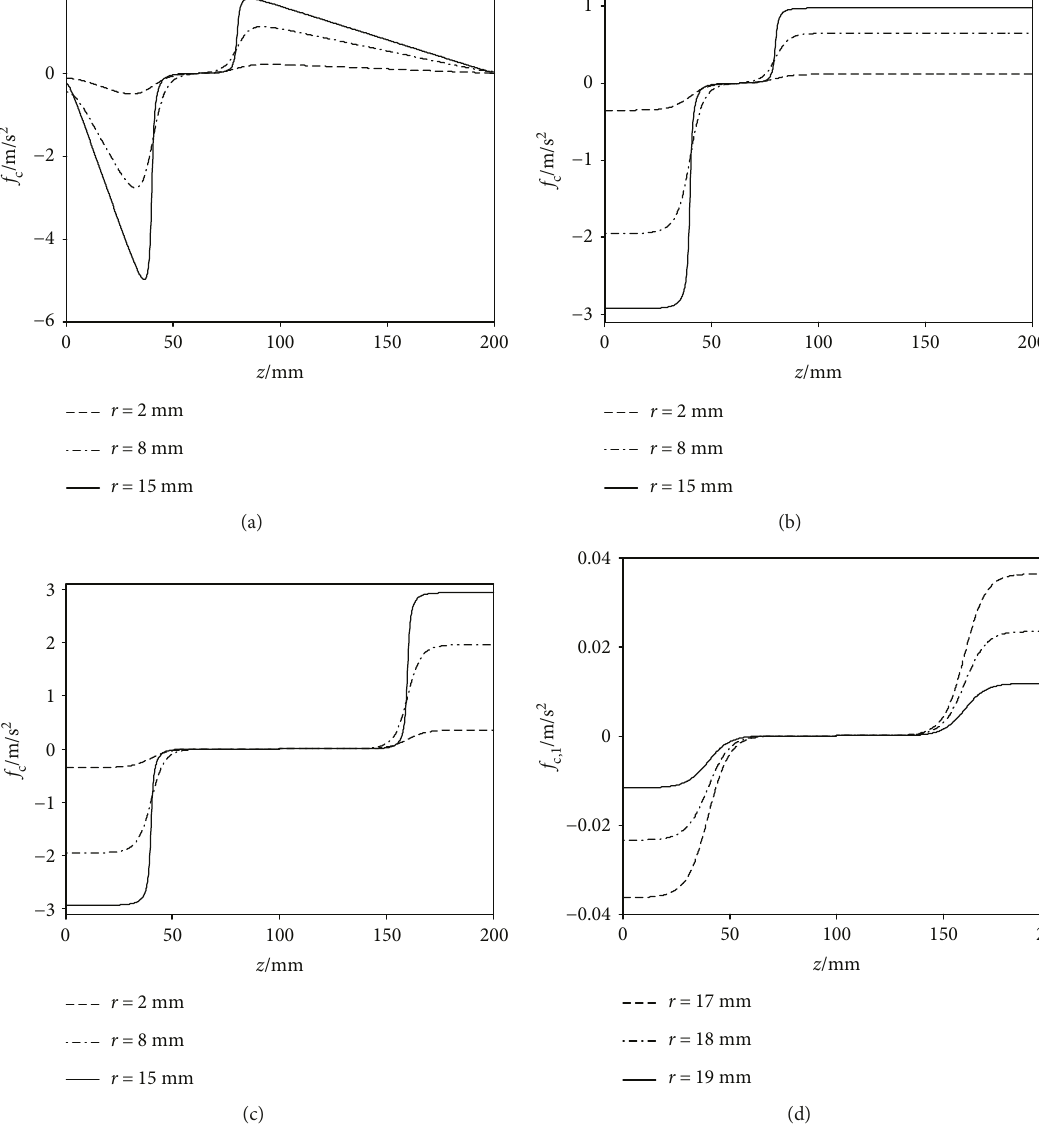
Figure 5: Distribution of the Coriolis force along the axial direction for di ff erent cases. (a) Distribution in vapor for case 2. (b) Distribution in vapor for case 3. (c) Distribution in vapor for case 1. (d) Distribution in liquid fi lm for case